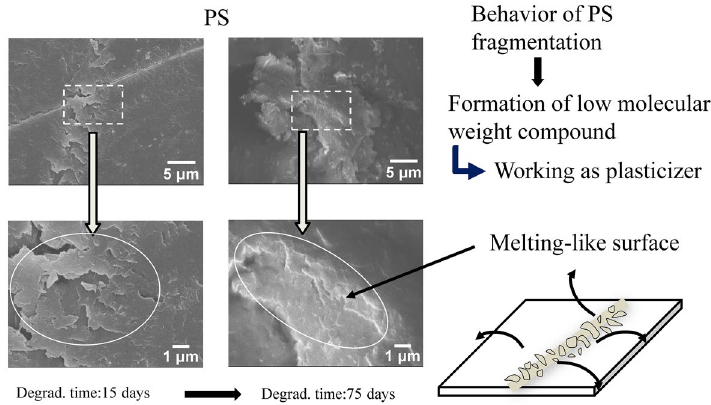
Figure 8. SEM photographs and fragmentation mechanism of PS in